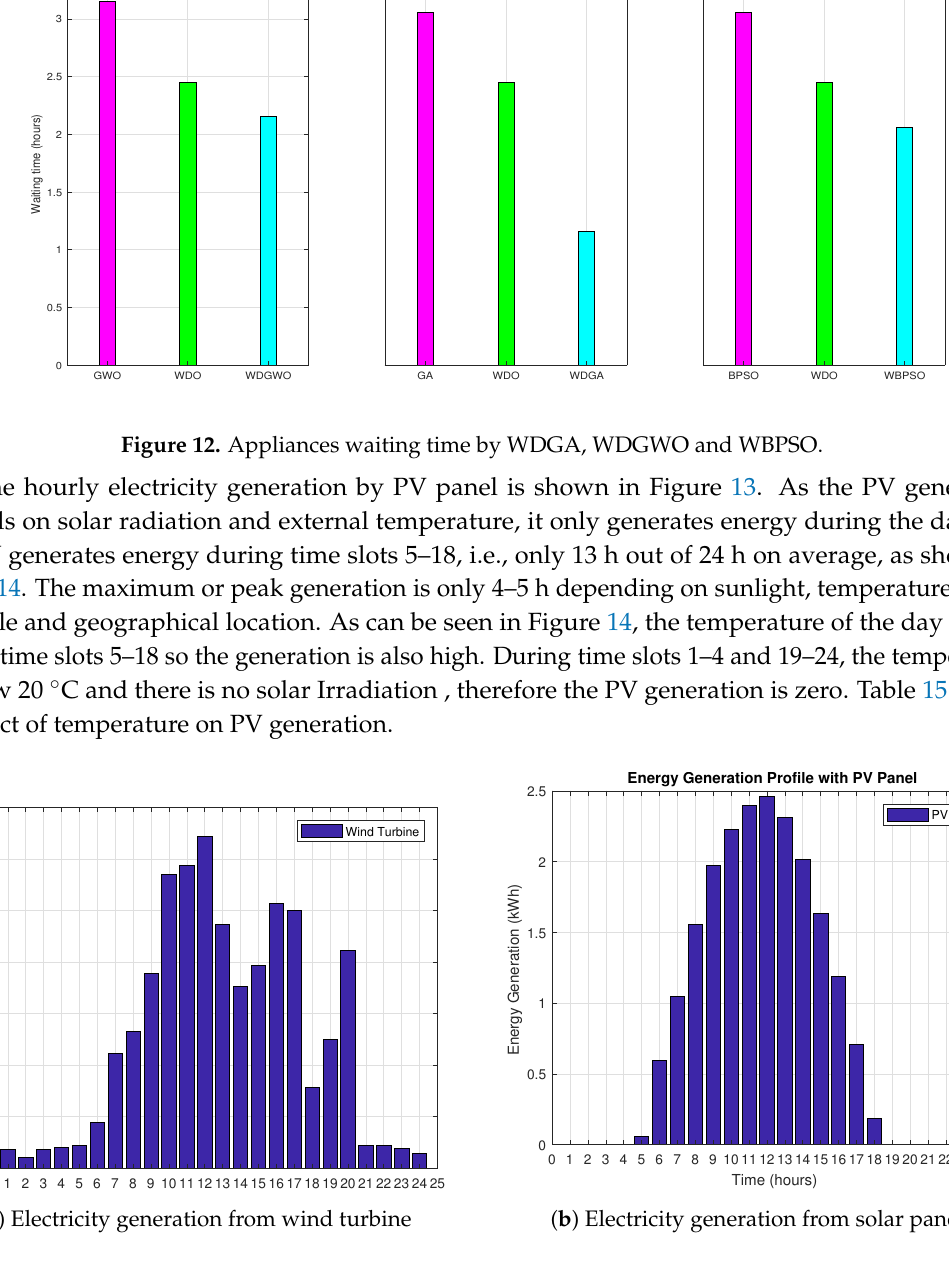
Figure 13. Hourly electricity